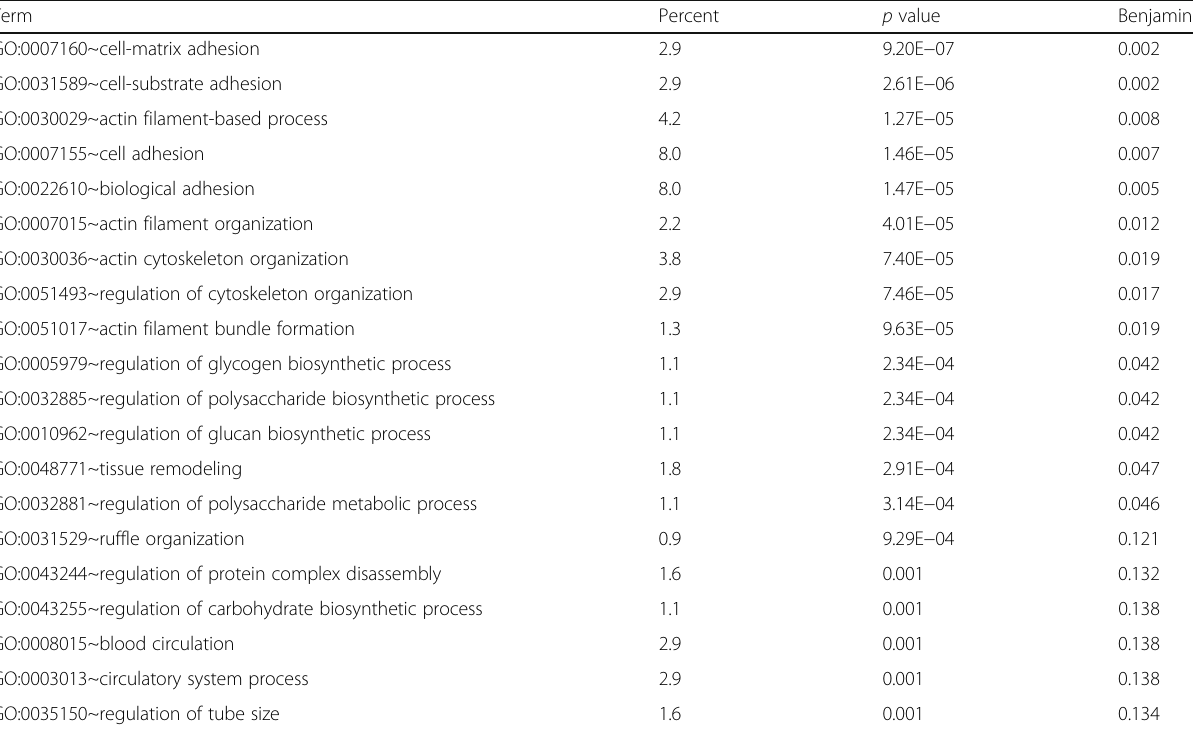
Table 5 Biological processes overrepresented in the genes with negative correlation with the SUV (from DAVID Bioinformatics Resources 6.7) Term Percent p